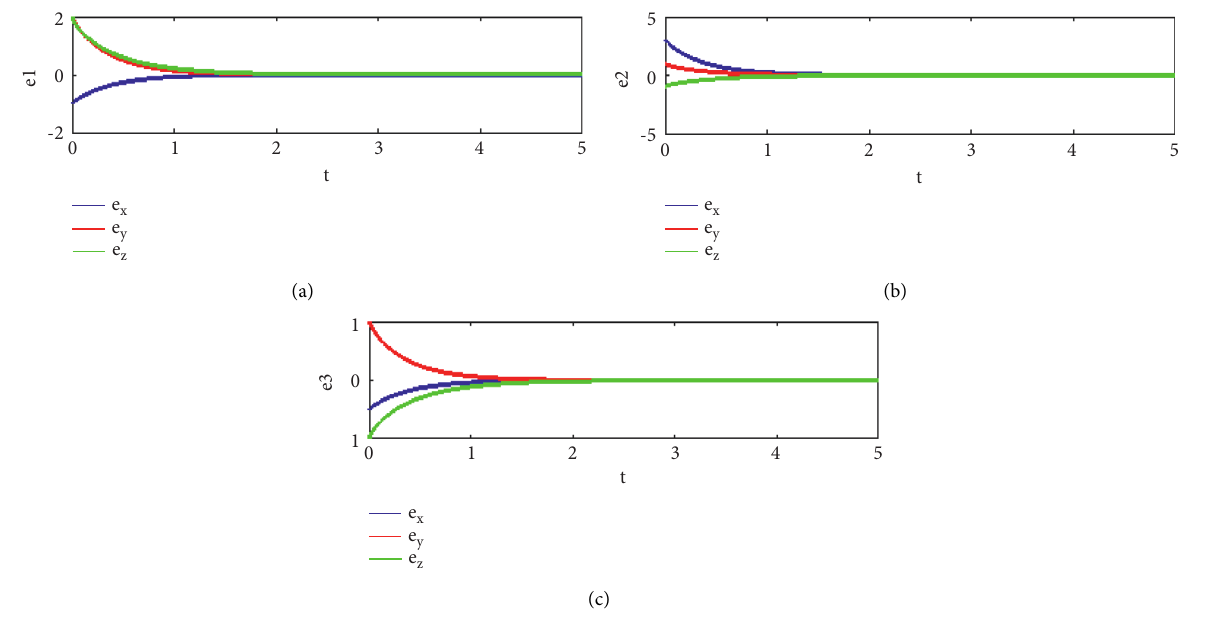
Figure 7: The error trajectories of leader and agents with c � 0 . 5 in Example 3. (a) The error trajectories of v0 and v1. (b) The error trajectories of v0 and v2. (c) The error trajectories of v0 and v3. Table 3: Average time to zero of the variables’ error with increasing c in Example 3.